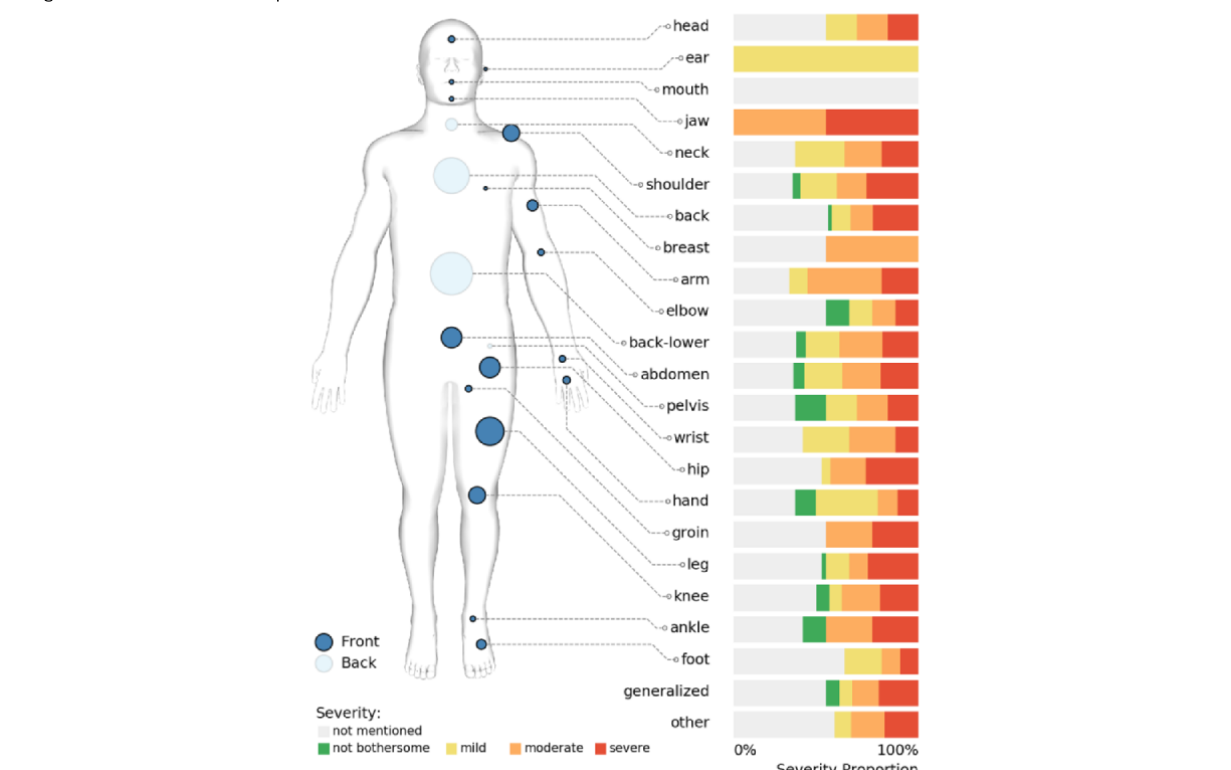
Figure 5. The annotated chronic pain episodes, grouped by body location and with corresponding severity distributions. The sizes of the blue circles on the figure reflect the relative frequencies within the annotated